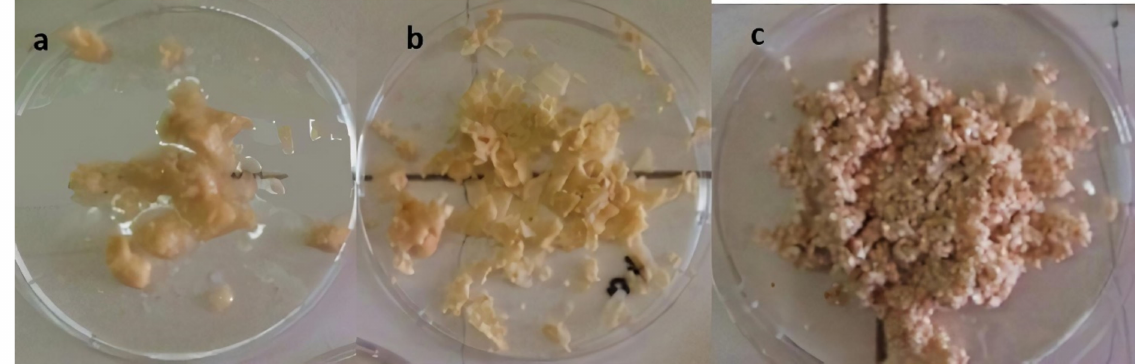
Figure 4. Images of eggshell membrane ( a , b ) and eggshell ( c ) obtained at the top and bottom of the foam separa- tor,